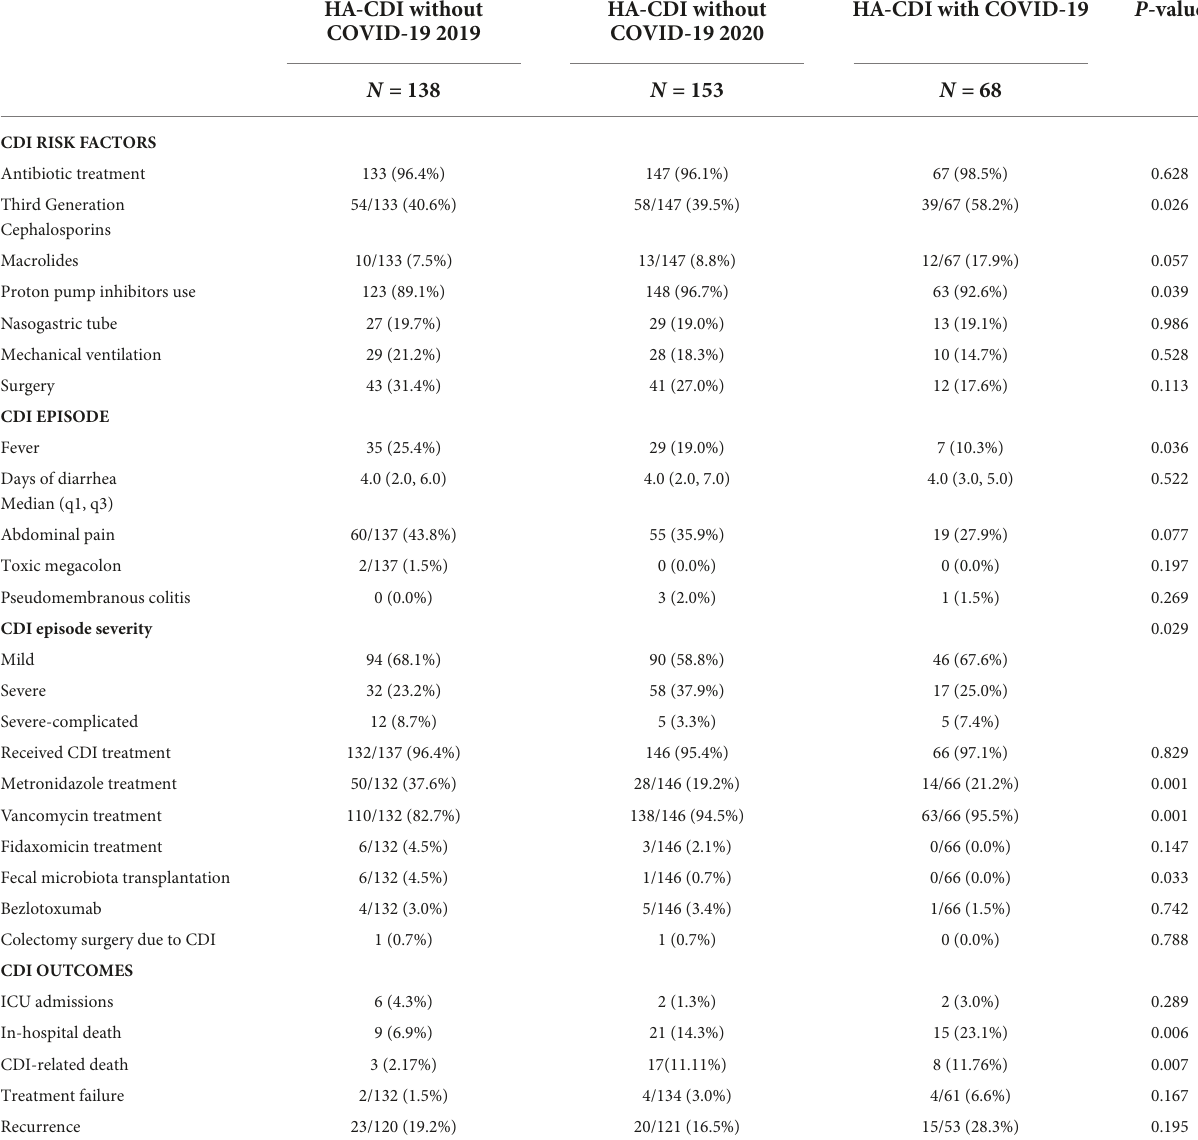
TABLE 3 Clostridioides difficile risk factors, episode characteristics, and outcomes in coronavirus disease and no coronavirus disease